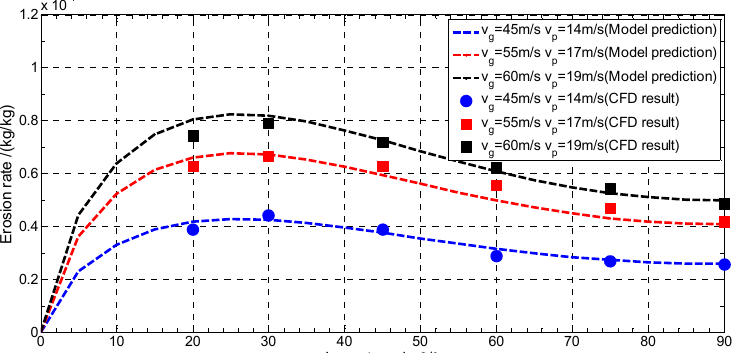
Figure 16. A comparison between the simulation and erosion models of the 6061 aluminum alloy specimen ( v g = ~45–60 m/s, v p = ~14–19 m/s, d p = 300 μ m, and θ = ~20°–90°). According to these images, the simulation results of the different materials at differ- ent angles, gas velocities, and particle velocities were close to the theoretical predictions. Due to the difference in hardness between the three specimens, the erosion rate of the Q235 carbon steel was slightly higher than that of the A304 stainless steel, while the ero- sion rates of both these materials were about 2.5 times that of the 6061 aluminum alloy. In addition, the erosion rate could be used to characterize the mass-loss rate. Given that the material density of the 6061 aluminum alloy was approximately one third of Q235 carbon steel and A304 stainless steel, it can be stated that the volume loss of these three materials was similar. 4.1.2. A Comparison of the Erosion Results at Different Angles and Particle Sizes When the same material (Q235 carbon steel) specimen was selected, with adjusted impact angles of 20°, 30°, 45°, 60°, 75°, and 90°, and particle sizes of 100 μ m, 300 μ m, and 500 μ m, respectively, the contrast diagram denoting the CFD erosion simulation results and erosion model is represented by Figure 17.